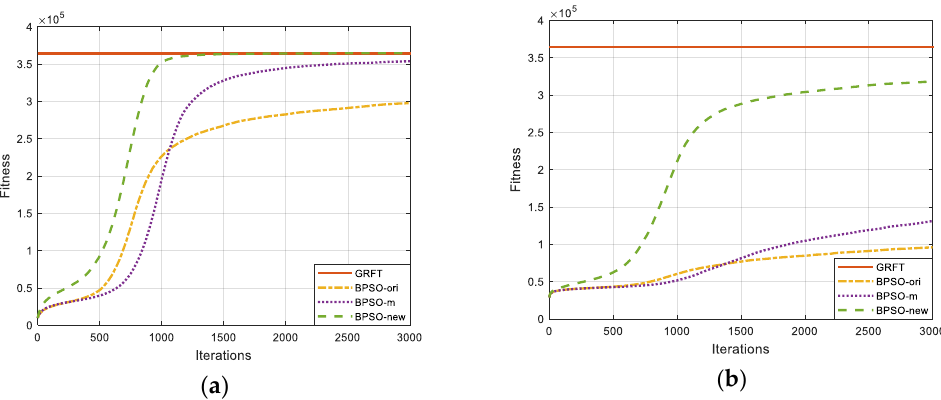
Figure 4. Average convergence of blind-speed sidelobes particle swarm optimization (BPSO)-based GRFT methods—( a ) signal-to-noise ratio (SNR) = 15 dB and ( b ) SNR = 5 dB.